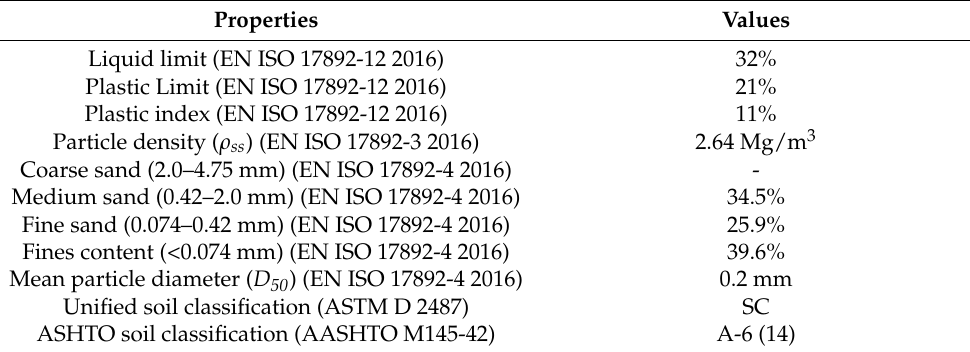
Table 1. Physical properties of the soil.